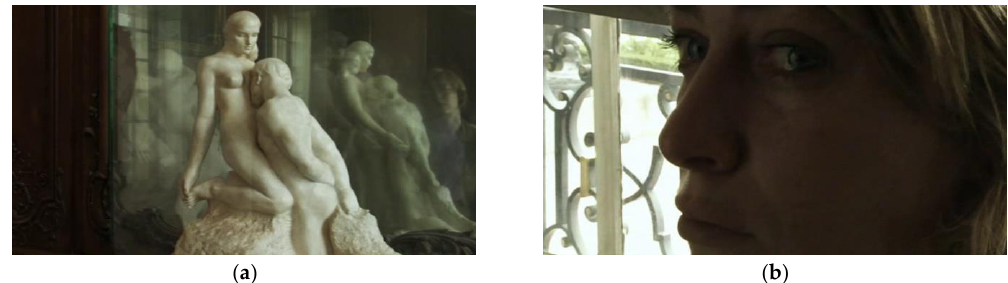
Figure 7. Frames from A Perfect Couple . A shot of Rodin's L’eternelle idole in which the sculpture is shown through its glass case, in whose surface Valeria Bruni Tedeschi’s reflection is clearly seen ( a ), and an extreme close-up that represents her personal experience of the art-works ( b ). Source: DVD edition by Intermedio (Spain).